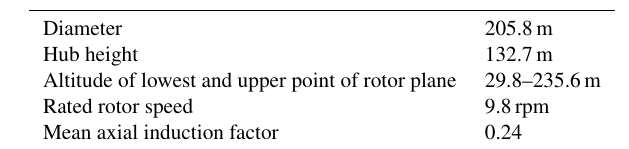
Table 1. Main characteristics of AVATAR